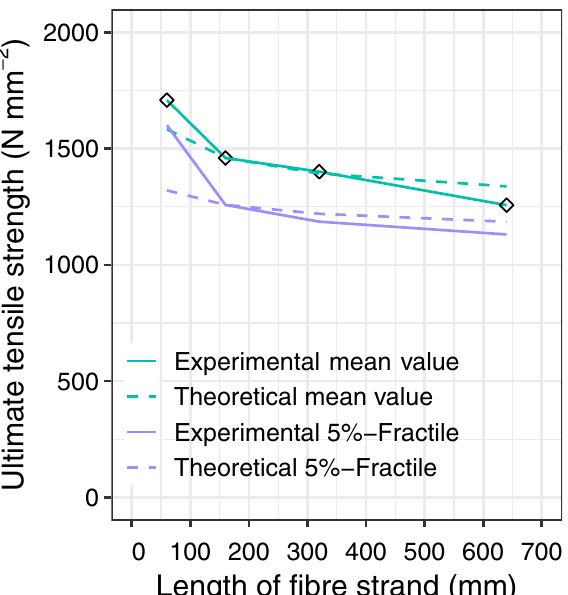
Figure 5. Ultimate tensile strength of the textiles depending on the length of the fibre strands.